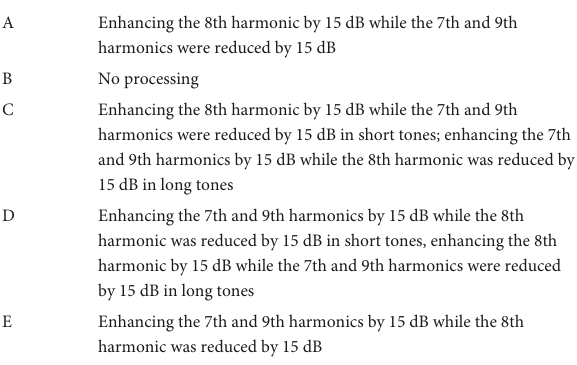
TABLE 1 Factors used for each of the five audio materials in investigation 1.